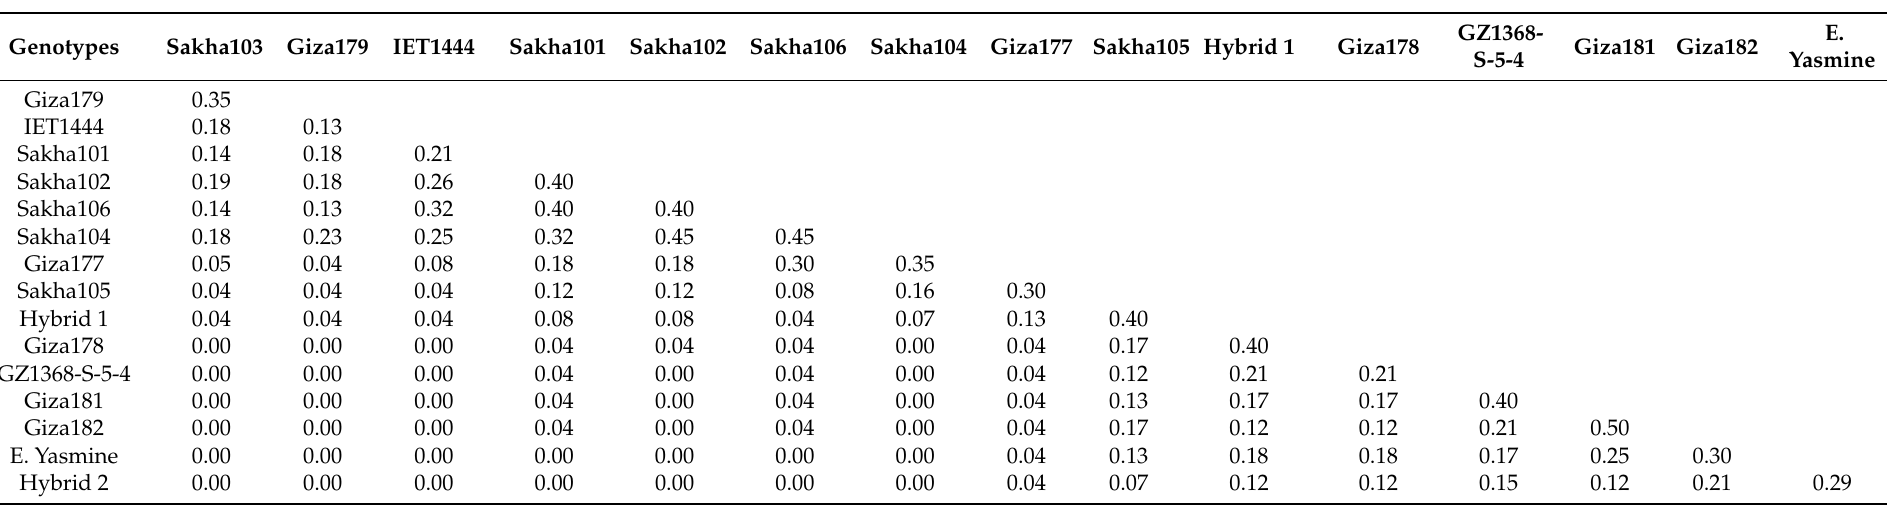
Table 10. Similarity coefficient among studied genotypes based on SSR